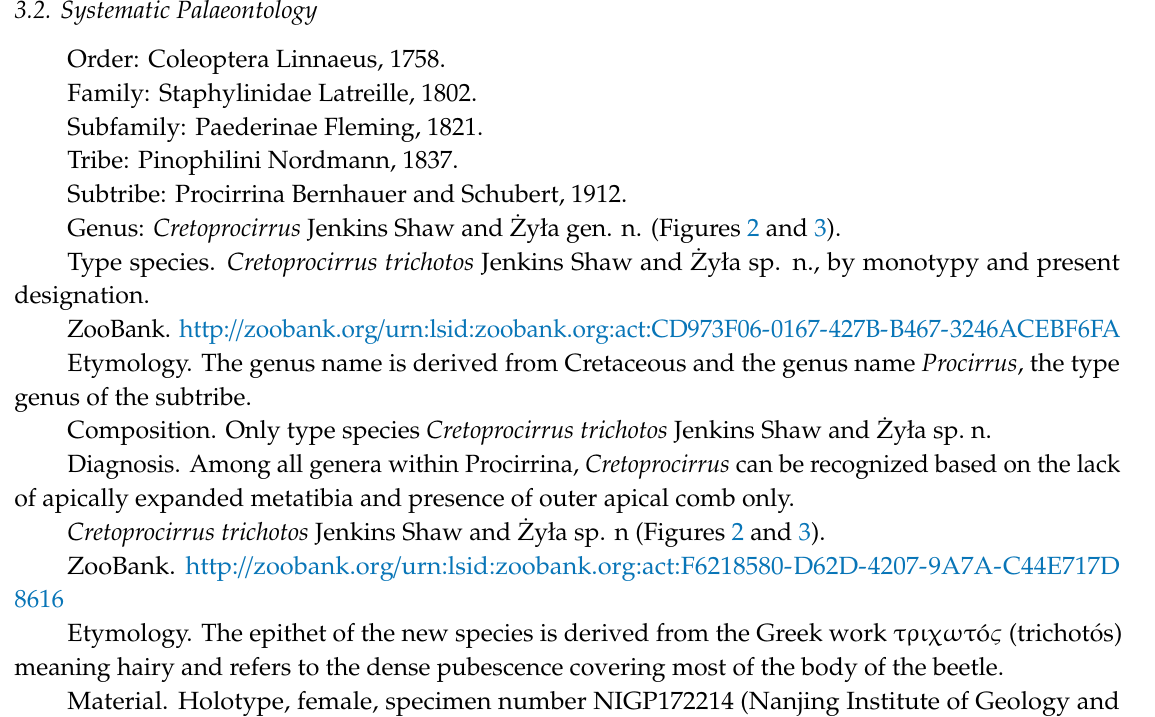
Figure 1. Fifty percent majority rule consensus tree from the Bayesian inference analysis of the morphological matrix. Numbers given at the nodes are posterior probabilities and bootstrap values (PP/BS).